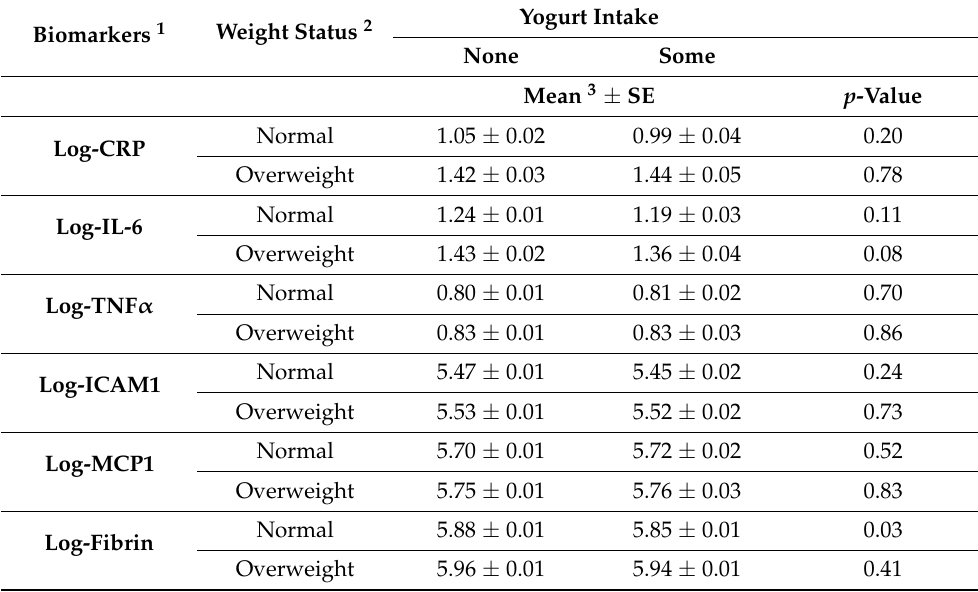
Table 3. Adjusted mean levels of inflammation biomarkers according to combined categories of yogurt intake and weight status.